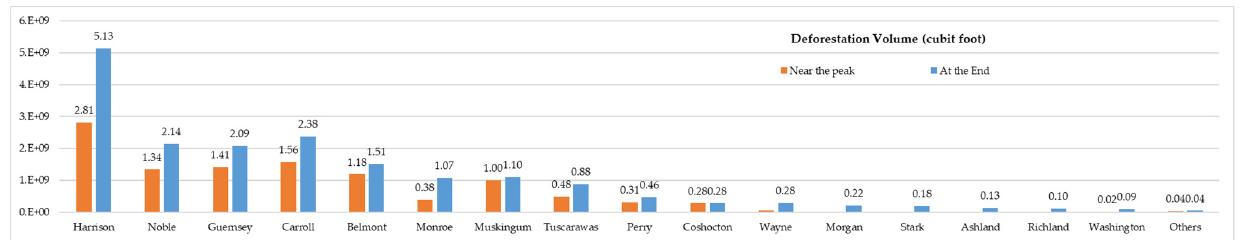
Figure 12. The deforestation volume due to unconventional shale gas extraction activities in the top counties near the peak and at the end of the boom. Orange bars indicate the deforestation volume from the start of the boom to the peak of the boom, while blue bars indicate the deforestation volume from the start of the boom to the end of the boom.